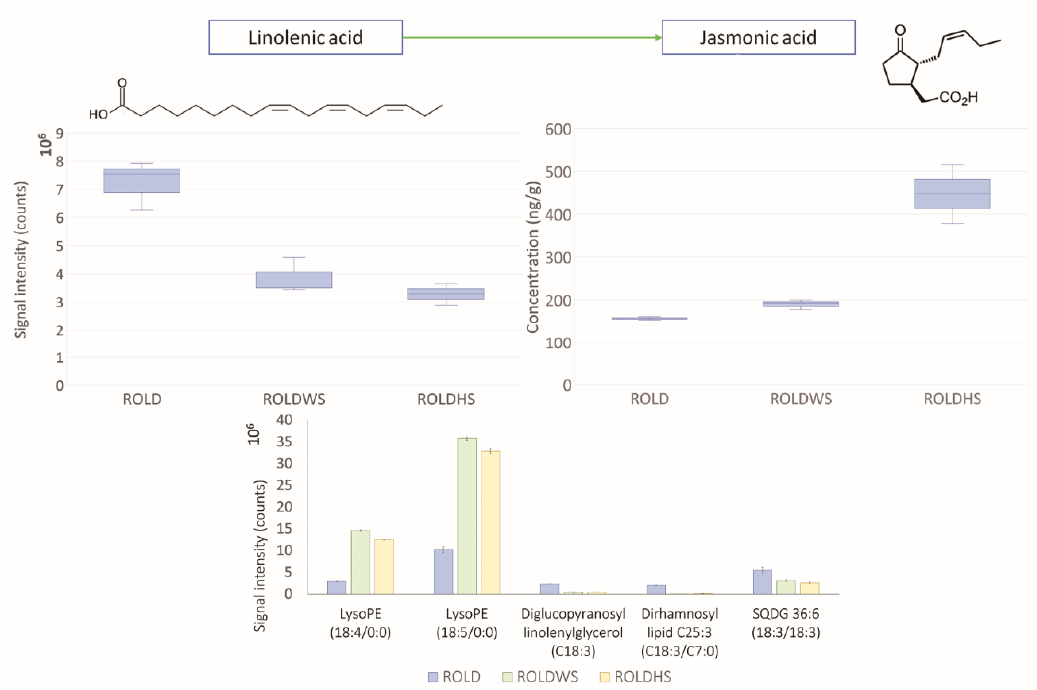
Figure 3. Levels of linolenic acid, jasmonic acid, and the main lipids which varied in both WS and HS samples. Error bars indicate standard deviation and 10 X specifies the unit of visualization.